Question: Reading the figure, is the described quantity rising or falling?
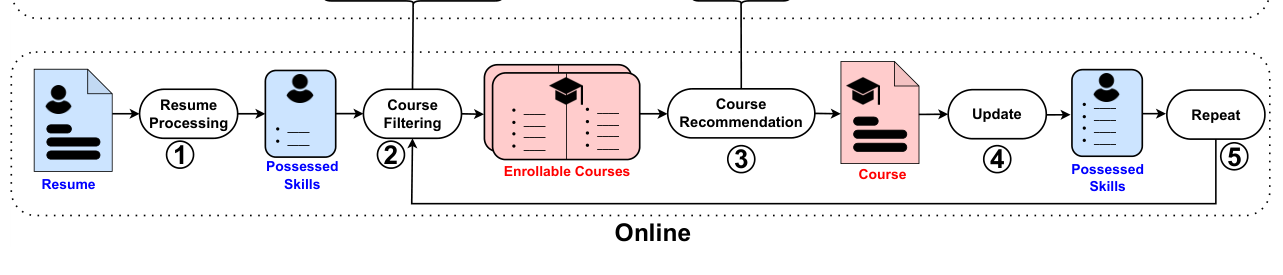
Answer: increasing